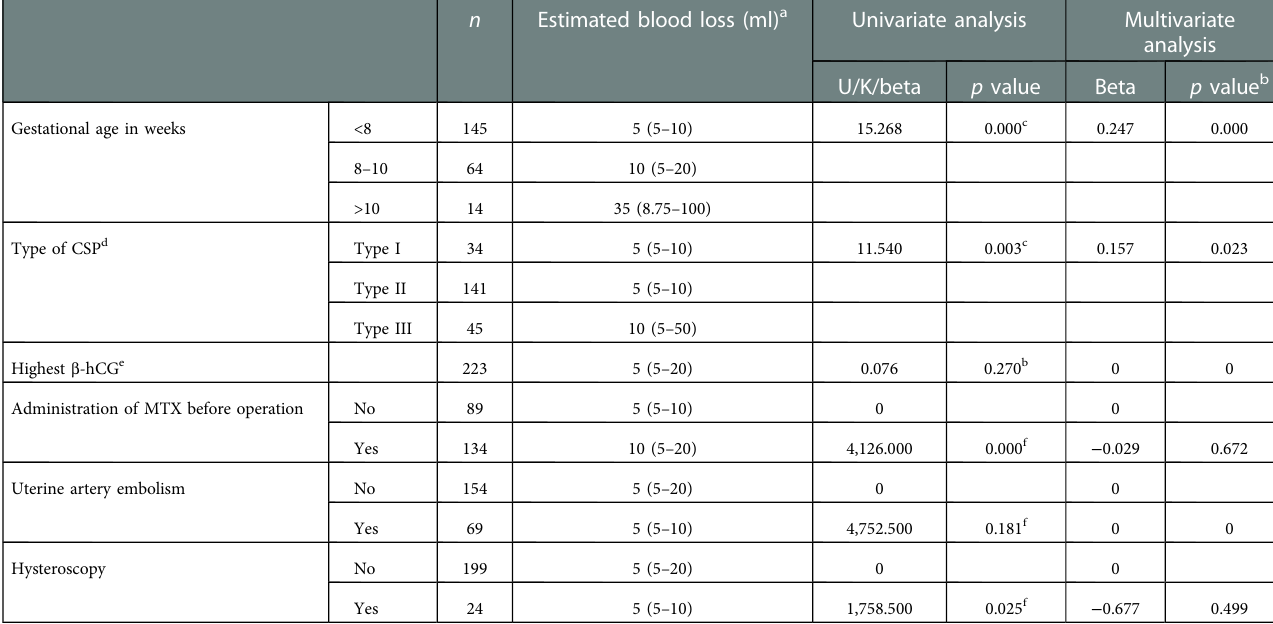
TABLE 2 Univariate and multivariate analyses of clinical characteristics and management in predicting estimated blood loss in patients with cesarean scar